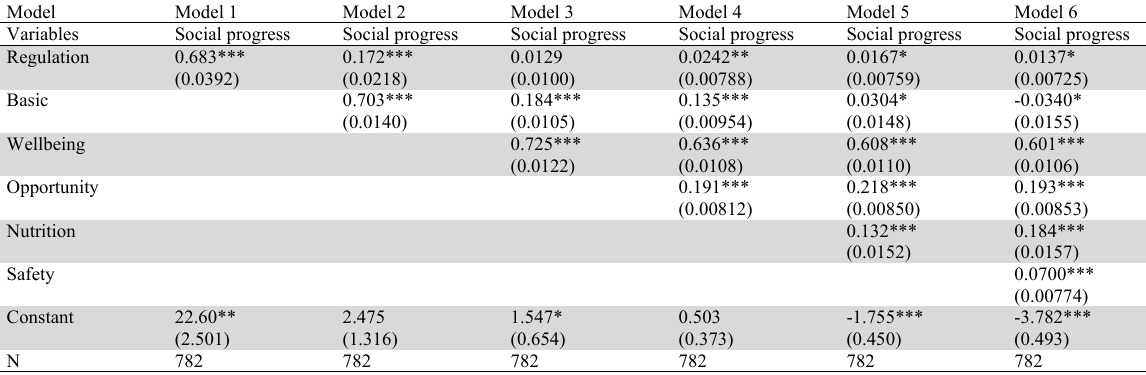
Regression Estimates for the Relationship between Business Regulation and Social Progress